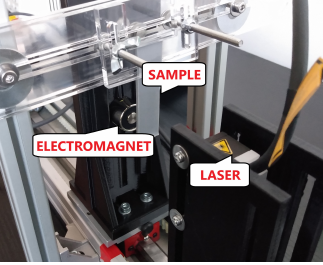
Figure 4. The laboratory set up for analysing the free oscillations of MRE